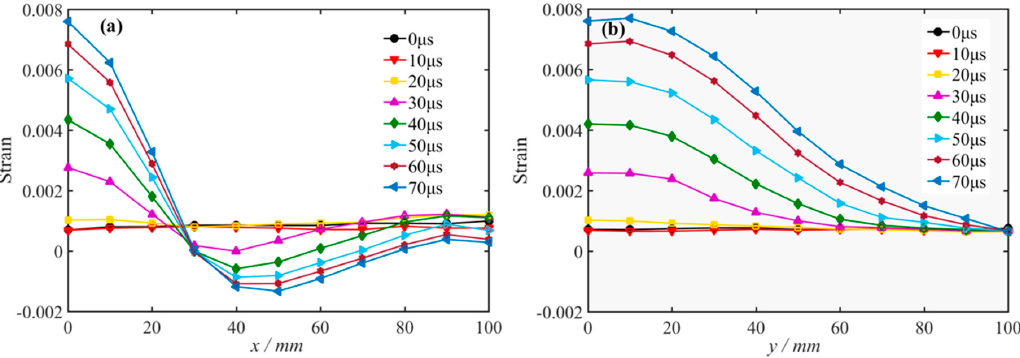
Figure 7. Variation of ε 1 at various points on the x and y axes at different moments in case of uniaxial static load: ( a ) x axis direction; ( b ) y axis direction.